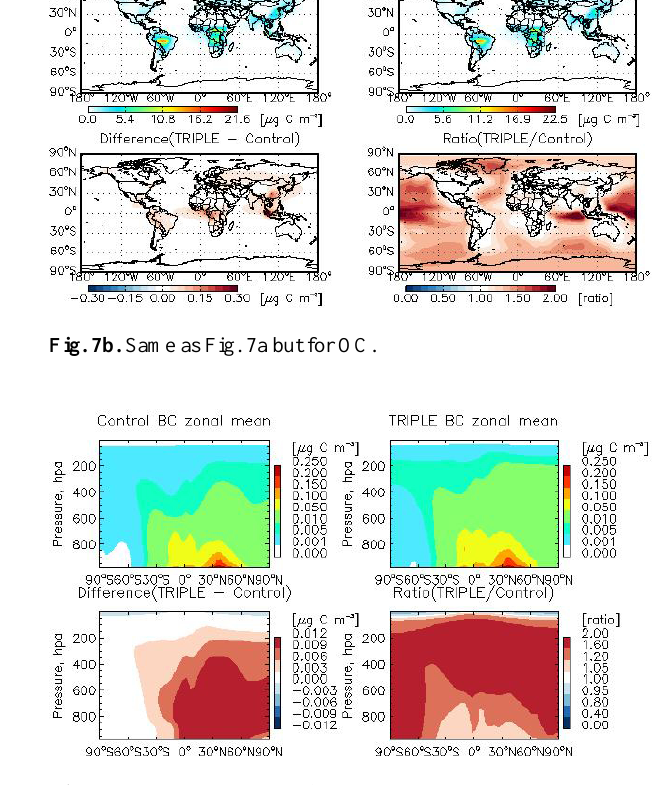
Fig. 7a. Model simulated annual mean surface BC concentrations from the sensitivity run versus the control run. (Upper left) BC con- centrations from the control run; (upper right) BC concentrations from the sensitivity run using the TRIPLE aging scheme; (lower left) differences between the sensitivity run and control run results; (lower right) ratio between sensitivity run and control run results.